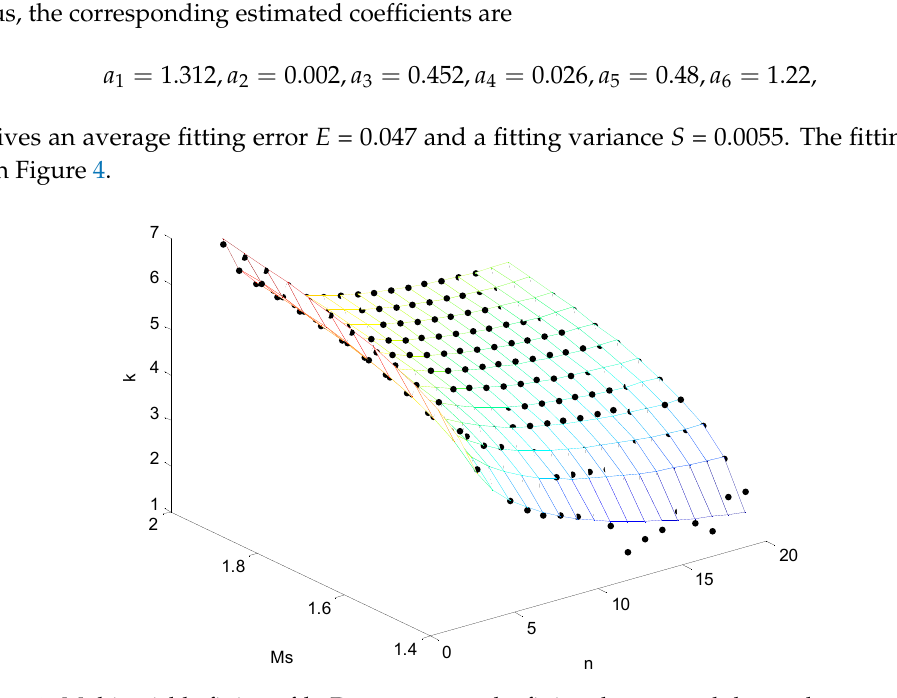
Figure 4. Multivariable fitting of k . Dots represent the fitting data set and the mesh represent the fitting results.